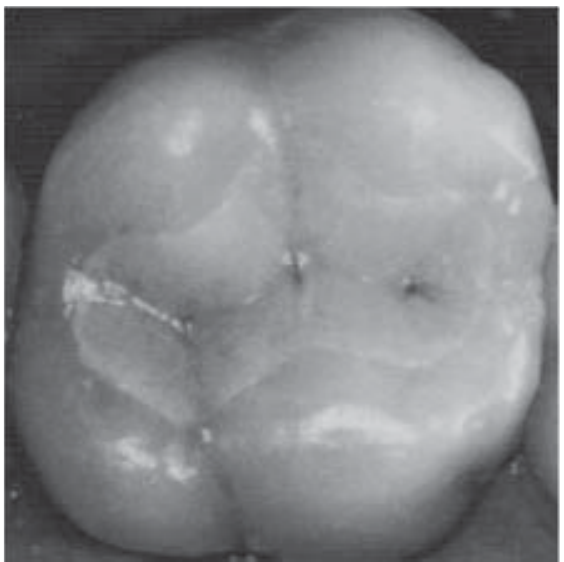
Figure 2: Ceramco inlay photograph evaluated after 40 months (T4). The restoration maintained high scores for each assessed category and